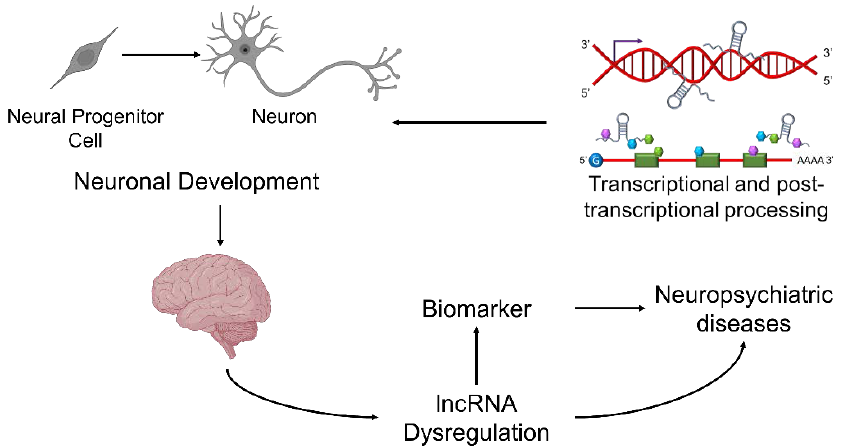
Figure 1. Nuclear lncRNAs function to regulate transcriptional and post-transcriptional processing which governs the development and function of neurons. Dysregulation of lncRNA in the central nervous system, specifically in neurons, is thought to contribute to the pathogenesis of SZ and may serve as a biomarker for diagnosis and treatment.